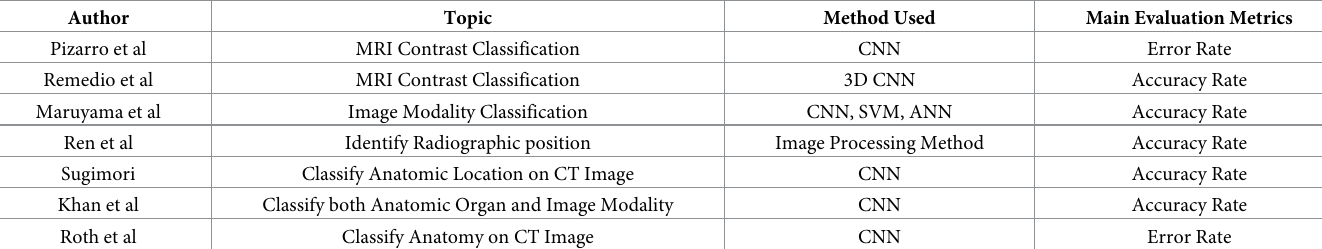
Table 7. Summary of medical image classification on image modality and/or anatomy by various